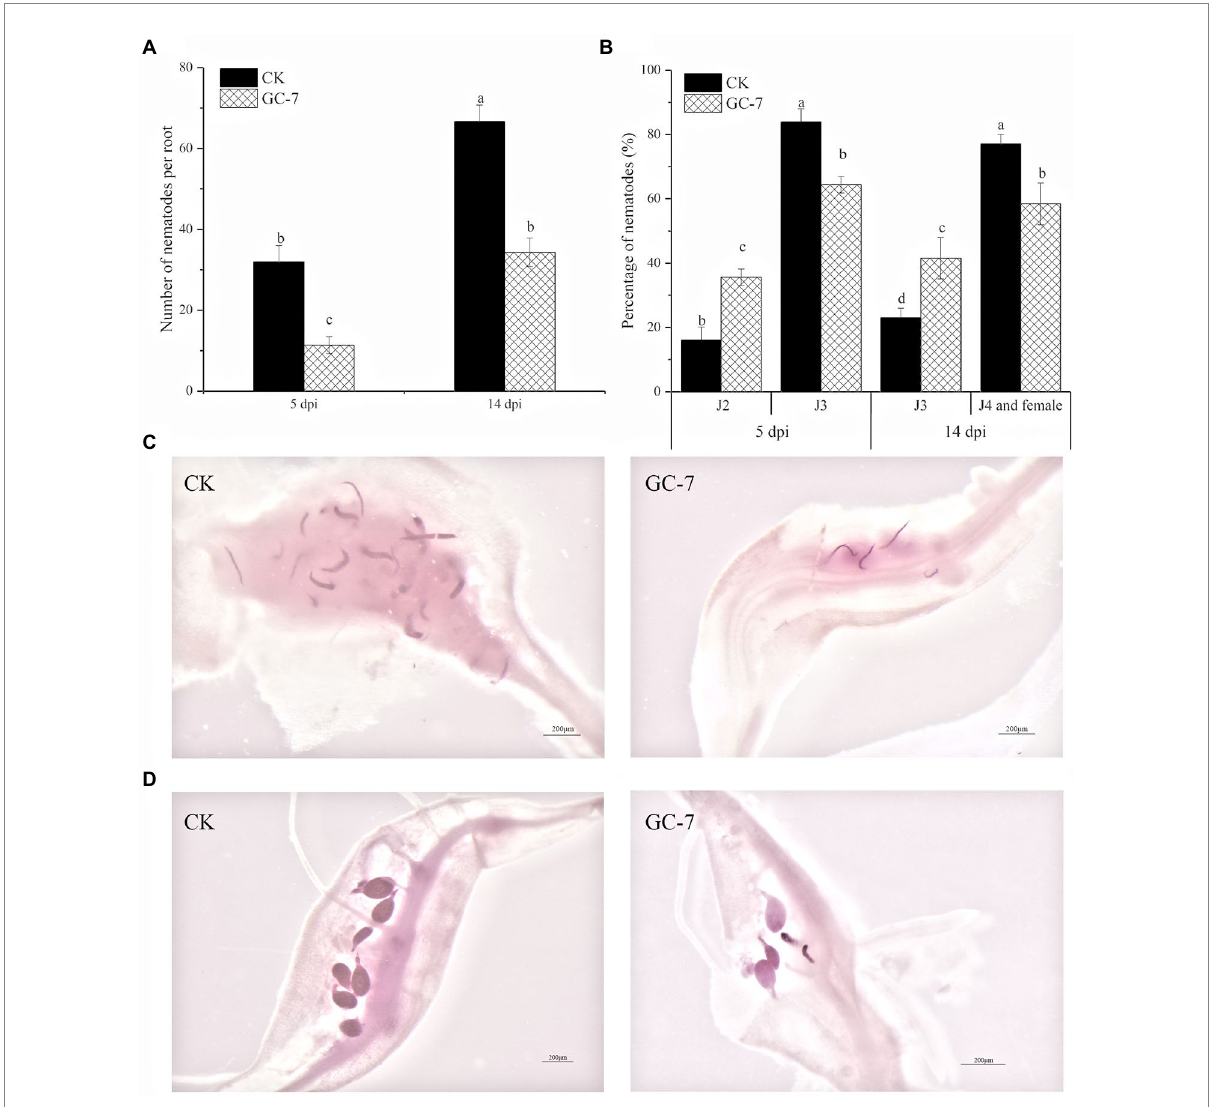
FIGURE 3 Infection and development of M. graminicola inside rice roots at 5 dpi and 14 dpi. (A) Penetration of M. graminicola in GC-7- and NB medium- treated (CK) rice roots. (B) The ratio of nematodes in rice roots at different developmental stages at 5 dpi and 14 dpi. (C) Nematodes in CK and GC-7-treated plants were photographed at 5 dpi. (D) Nematodes in CK and GC-7-treated plants were photographed at 14 dpi. The roots of rice seedlings were immersed in a 50% GC-7 strain fermentation culture (1 × 10 9 cfu/ml) for 8 h, and roots soaked in 50% NB medium for 8 h were used as controls. Each plant was inoculated with about 100 J2s. Scale bar = 200 μ m. The bars in the different graphs represent the mean ± SE of data from three independent biological replicates, each containing eight individual plants. Different letters indicate statistically significant differences (Tukey’s multiple range test at p ≤